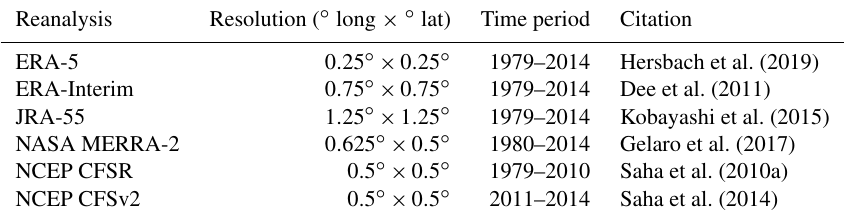
Table 2. Reanalysis data sets used in this